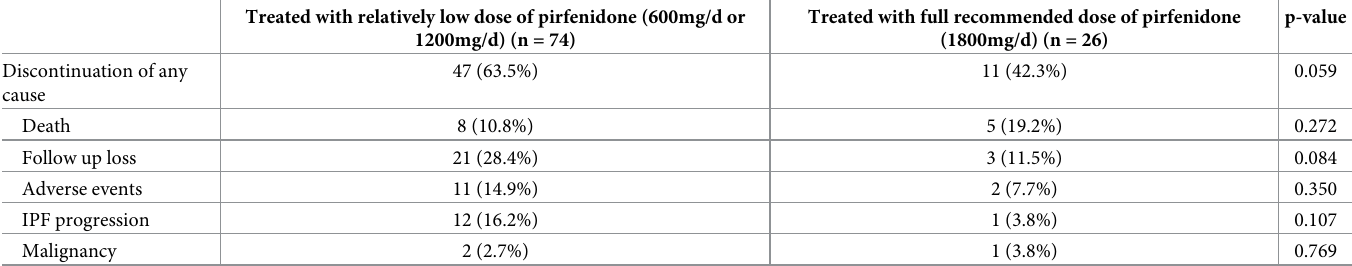
Table 9. Comparison of cause of pirfenidone discontinuation between patients who were treated with full recommended dose of pirfenidone (1800mg/d) and rela- tively low dose of pirfenidone (600mg/d or 1200mg/d). Treated with relatively low dose of pirfenidone (600mg/d or 1200mg/d) (n =